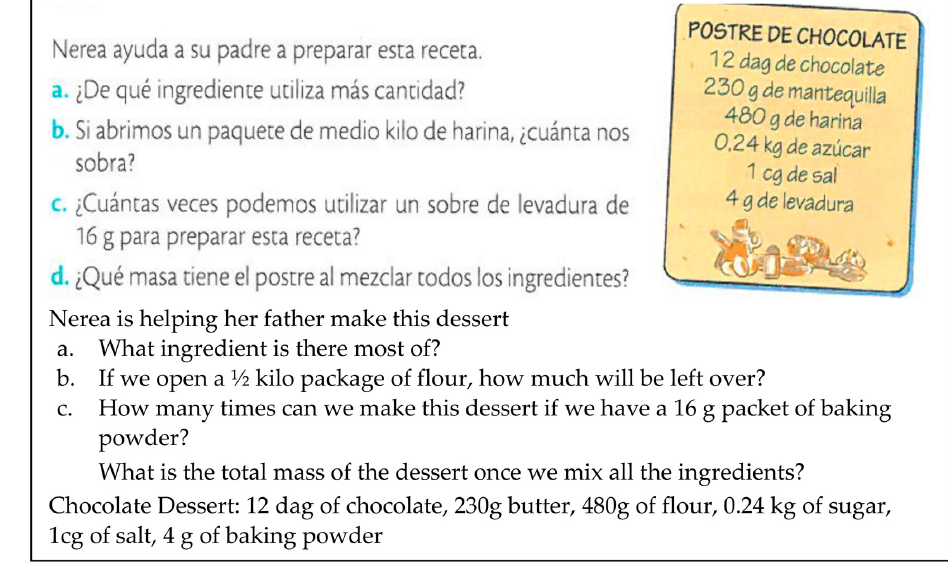
Figure 2. Sample unit of analysis.